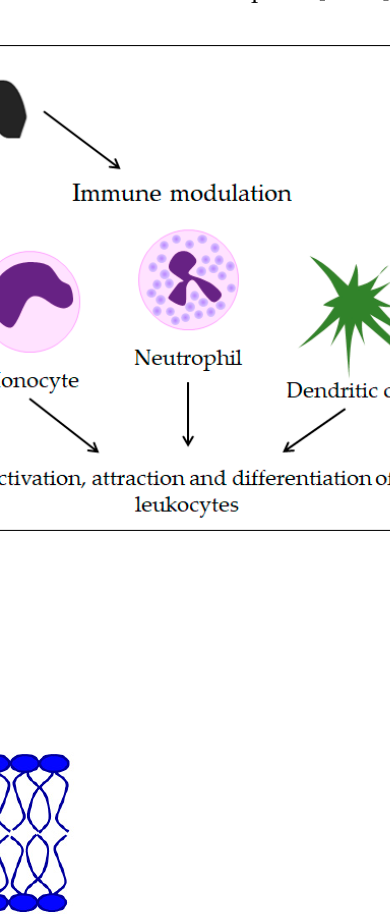
Figure 1. Mechanisms of AMPs action.